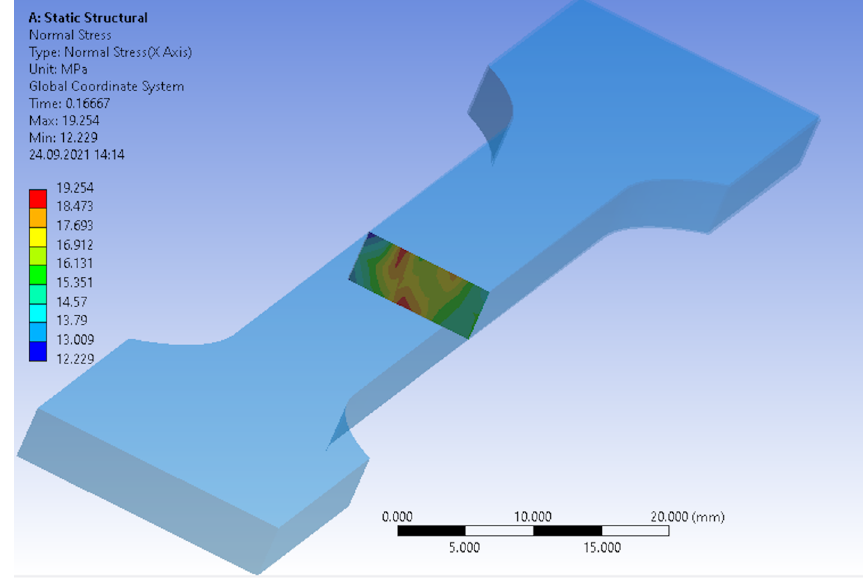
Figure 6. Cross-section of the specimen with visible stress distribution according to fiber orienta- tion.